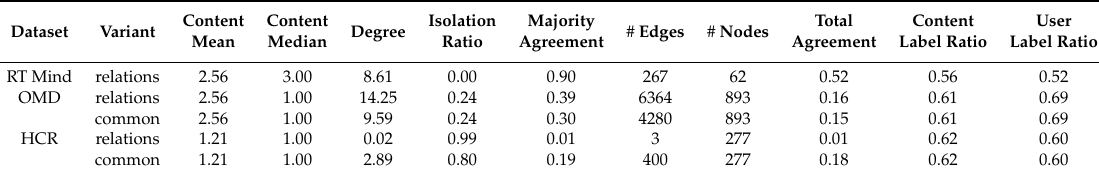
Table 2. Statistics of the networks gathered for each